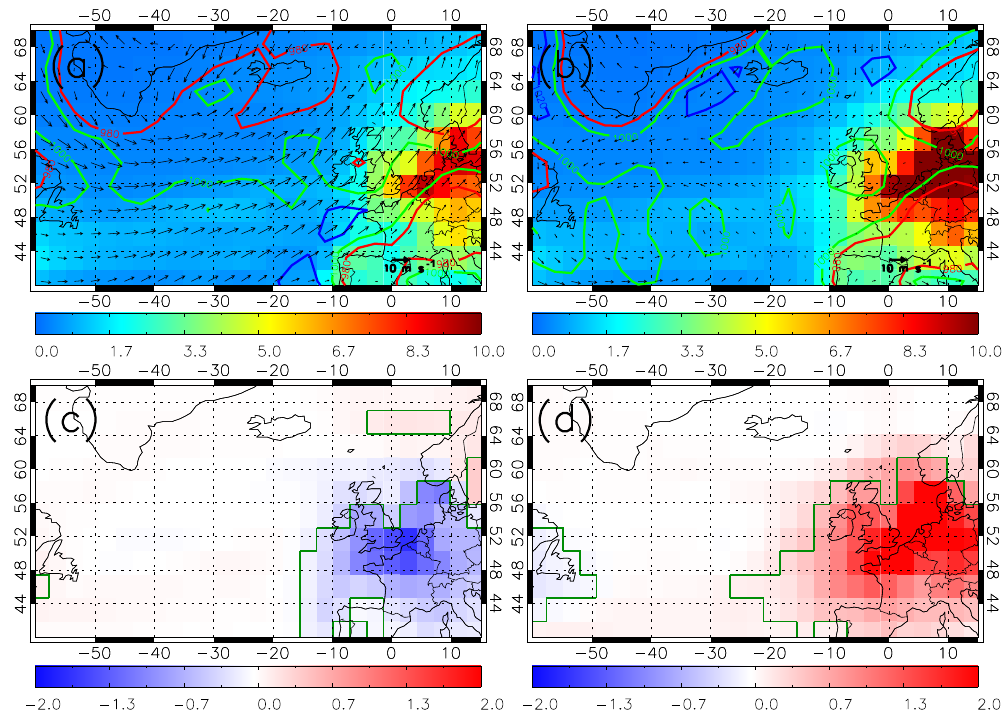
Figure 6. TOMCAT troposphere column NO 2 (10 15 moleculescm − 2 ) averaged between 2006 and 2015 sampled under the wintertime (NDJF) NAO. Panel (a) NAO positive phase, (b) NAO negative phase, (c) shows the NAO positive phase anomaly relative to the wintertime average and (d) shows the negative NAO phase anomaly relative to the wintertime average. Wind vectors show the horizontal 10m winds and the red, green and blue contours represent 980, 1000 and 1020hPa surface pressure. Green polygon-outlined regions in (c) and (d) highlight significant differences at the 95% confidence level based on the